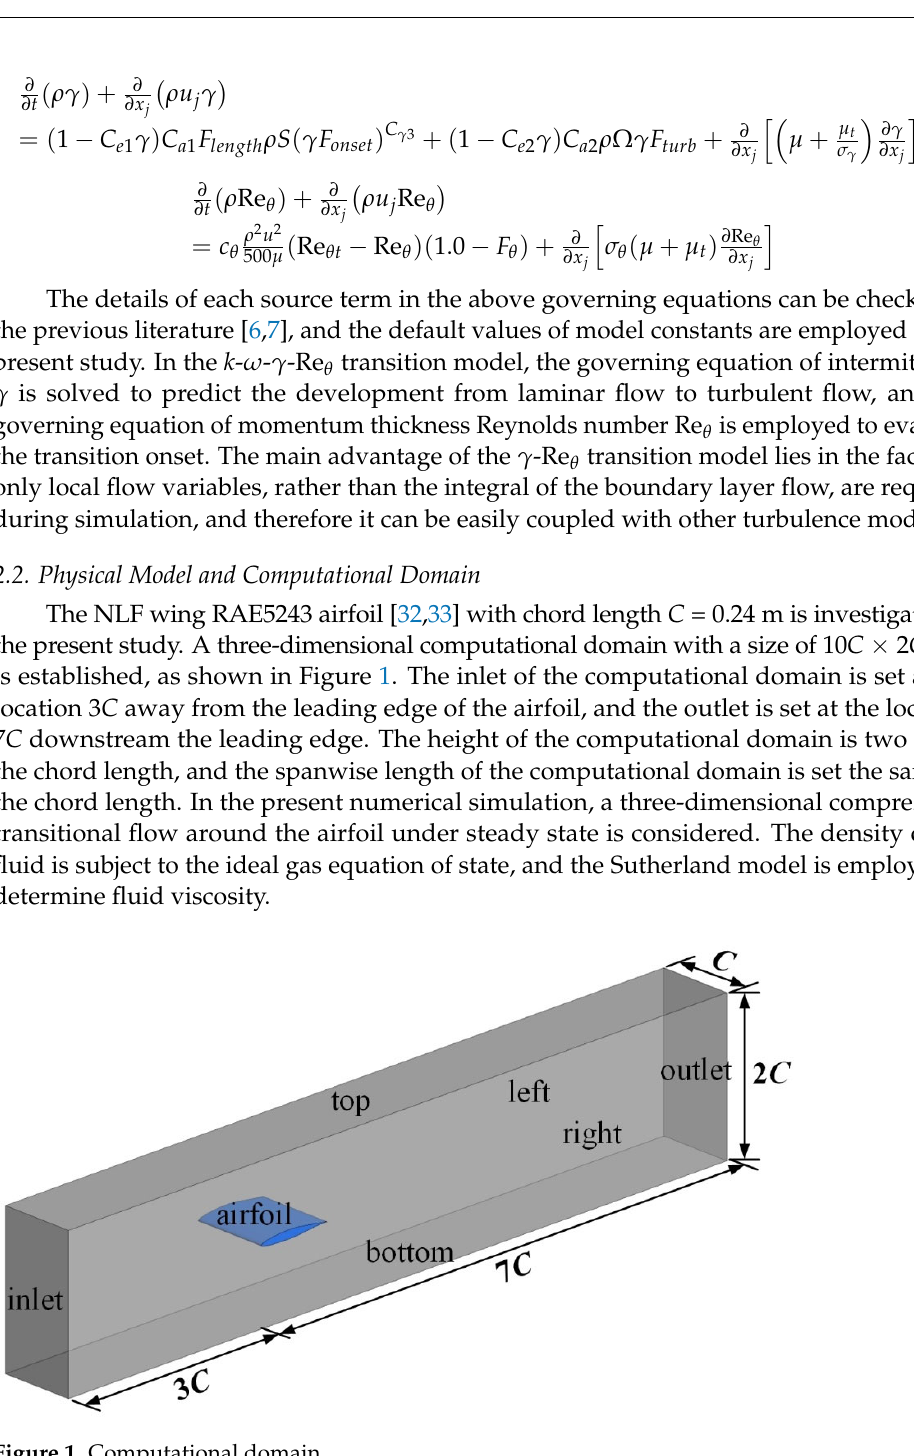
Figure 2. Mesh distribution. 2.3. Numerical Settings The commercial CFD software ANSYS Fluent 19.0 is employed to solve the steady transitional flow around the RAE5243 airfoil. The k ‐ ω ‐ γ ‐ Re θ turbulence and transition cou ‐ pled model described in Section 2.1 is applied in the present simulation. The pressure ‐ based solver is used to simulate these subsonic and transonic flows, and the SIMPLEC algorithm is used for pressure ‐ velocity coupling. For the boundary conditions, a pressure far ‐ field condition is given at the inlet, with total temperature of 303 K and total pressure